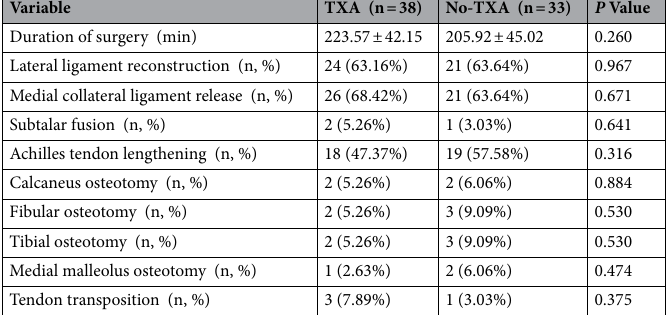
Table 2. Details of average duration of surgery and associated procedures between the two groups.